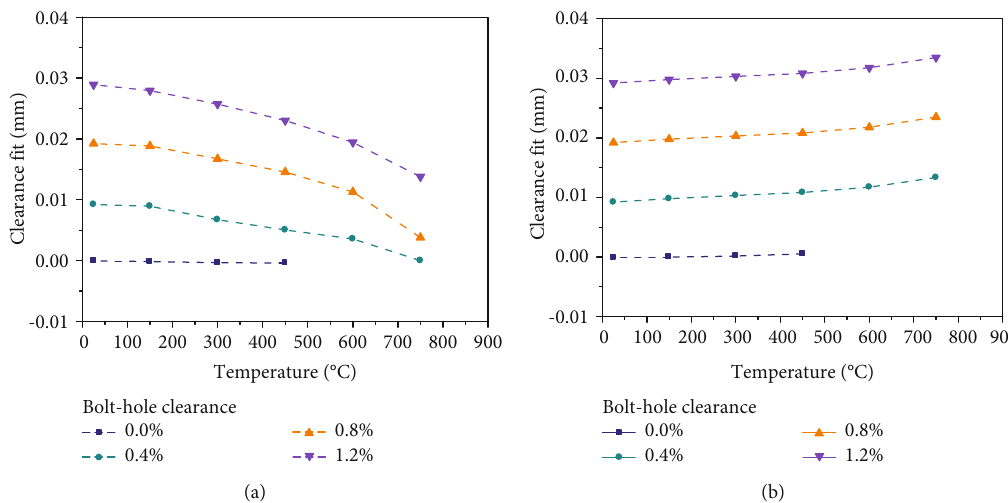
Figure 7: Variation of bolt-hole clearance with temperature for the studied CMC and superalloy bolted joint. (a) CMC plate. (b) Superalloy